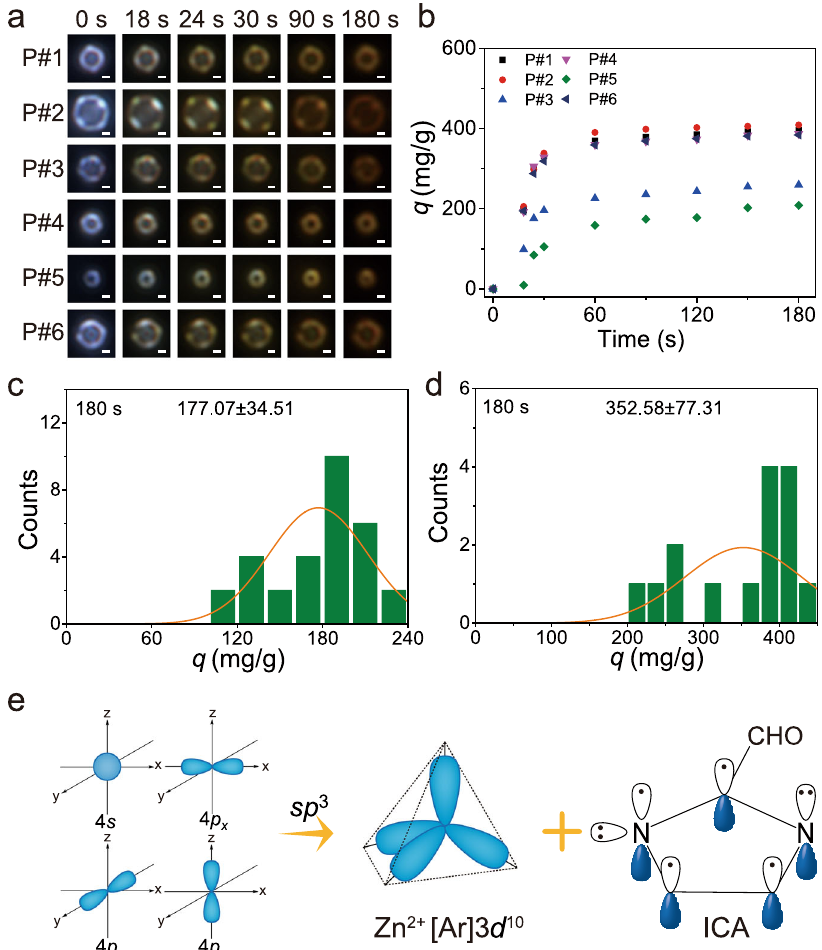
Fig. 5 Visualization of gaseous I 2 adsorption on defected ZIF-90 particles. a Time sequential DFM images of gaseous I 2 adsorption on six representative defected ZIF-90 particles (scale bar: 1 μ m) and ( b ) the corresponding adsorption kinetic. Histograms of the adsorption amount ( q ) for ( c ) ZIF-90 and ( d ) defected ZIF-90 particles. e Formation of sp 3 orbitals from 4 s and 4 p orbitals of Zn 2 + and molecular orbital structure of ICA.